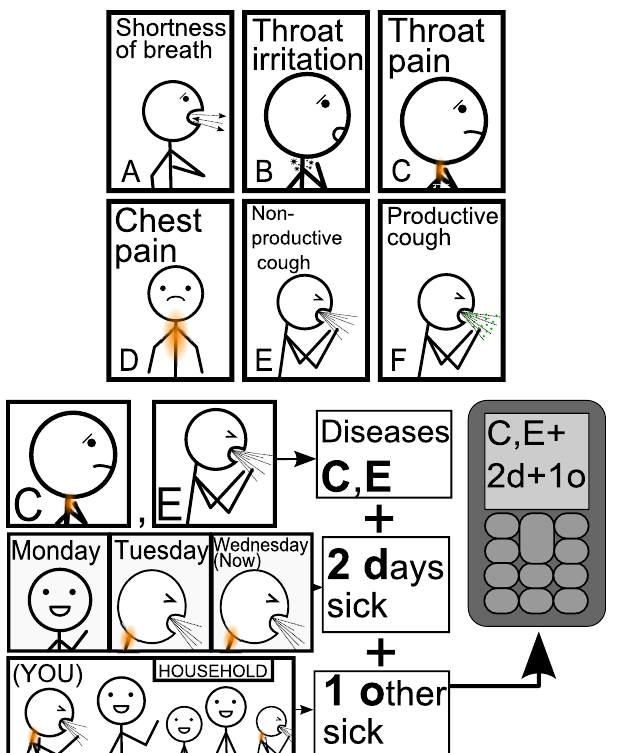
Fig 1. Sample of symptom codes, and pictogram explaining report structure. Depicted are a small subset of symptom codes, which includes febrile and gastrointestinal symptoms alongside some of the respiratory symptoms. Message structure consisted of alphabetical symptom codes, the number of days sick, and the number of other household members with the same illness. The first of these report elements is for the reporting of any current illness, number of days sick is intended to facilitate the distinction of different ‘ bouts ’ of illness, and the reporting of other household members sick with the same illness provides both an indication of household-clustering of illness, and allows for the testing of report consistency between household